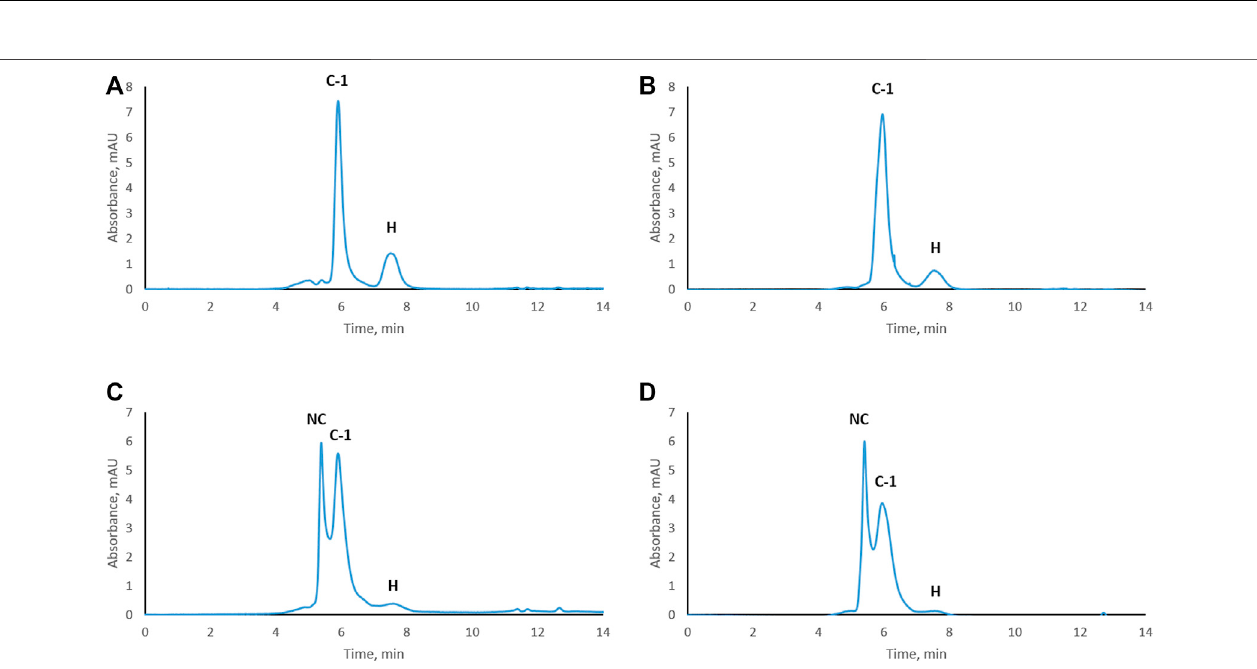
FIGURE 2 | Size-exclusion chromatograms of the trastuzumab – HER2 complex stressed under physiological conditions. Complex stressed for 1 week (A) , 2 weeks (B) , 3 weeks (C) , and 4 weeks (D) . NC, new complex; C-1, complex-1; H, HER2. UV absorbance was measured at 280 nm.